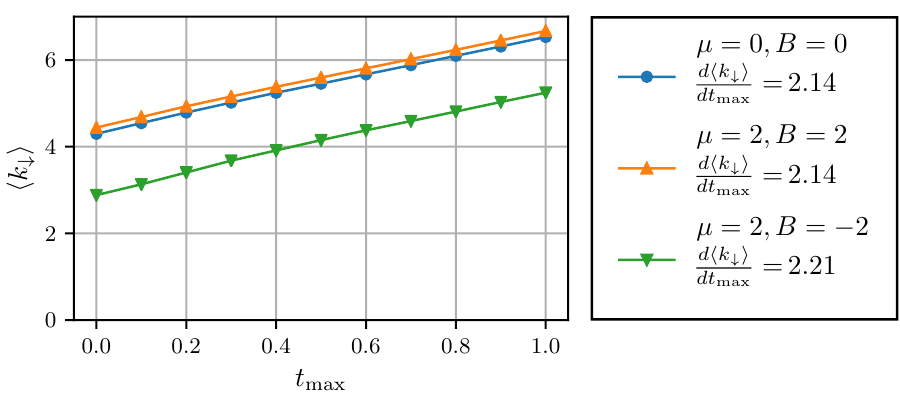
Figure 7: Average CT-1 / 2-HYB expansion order vs. t µ , B . Although the initial (equilibrium) average expansion order depends on the magnetic field B and chemical potential µ , the growth rate of the expansion order is hardly